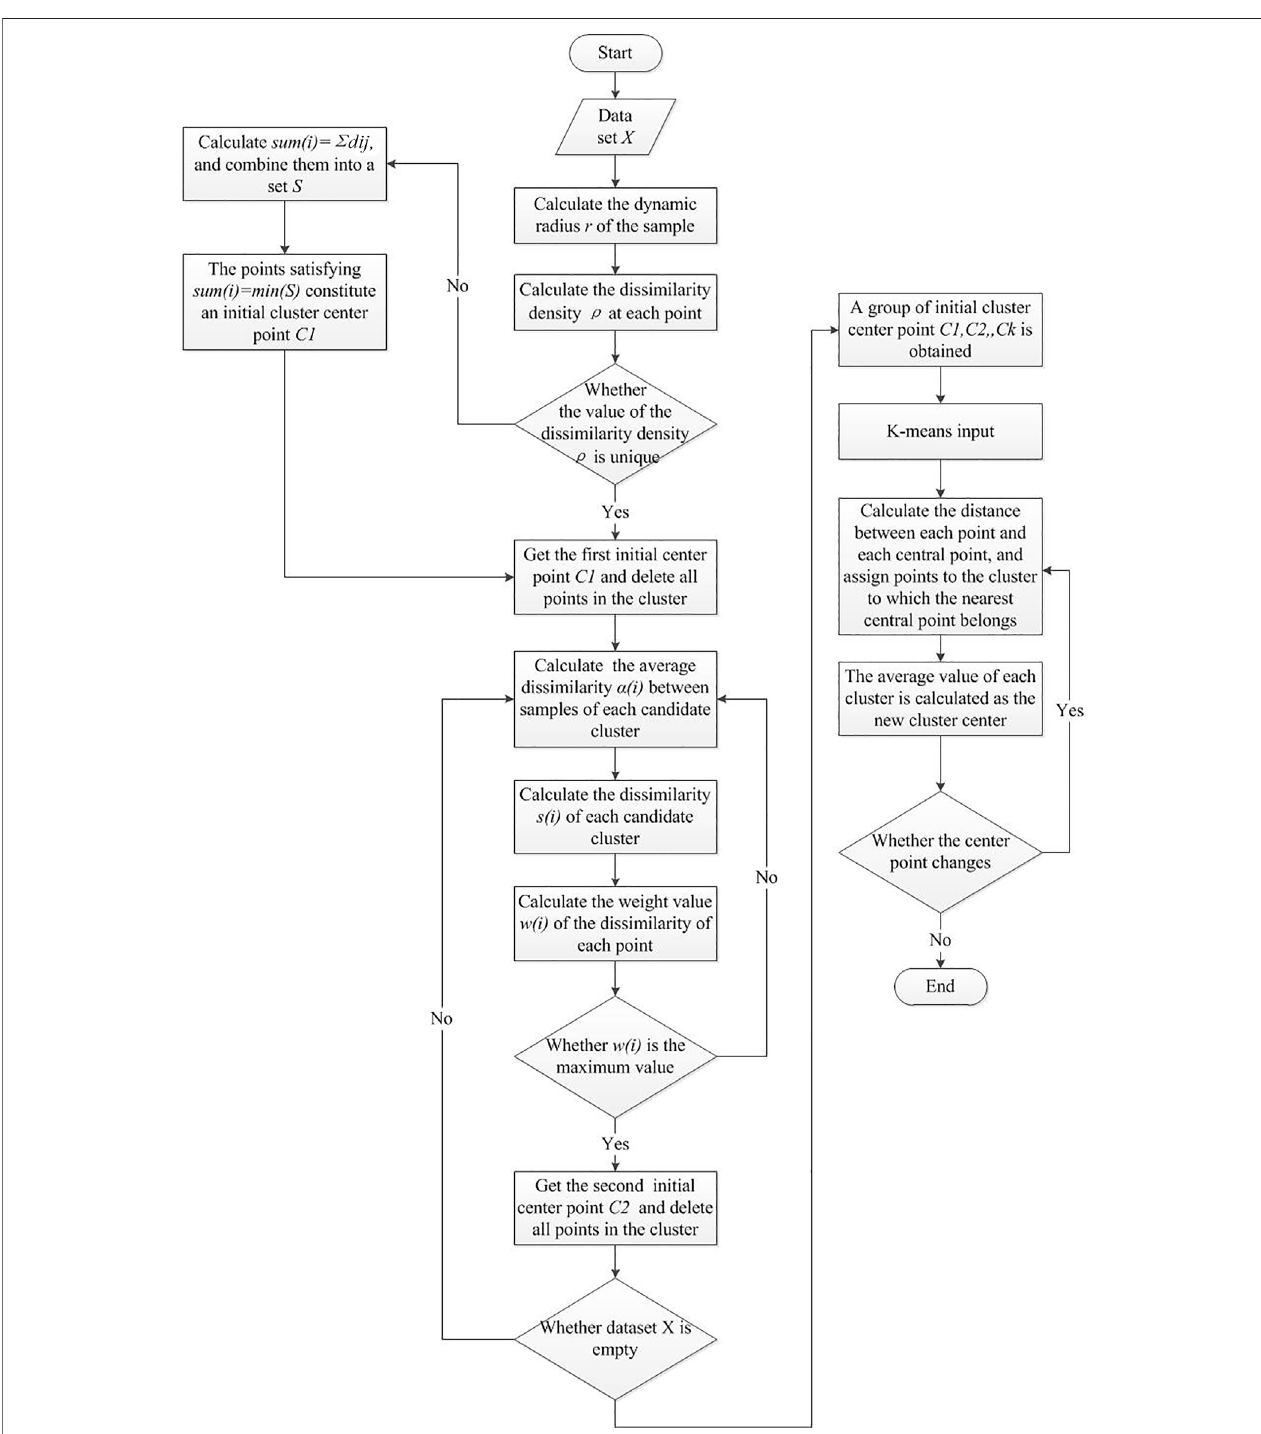
FIGURE 3 | Algorithm block